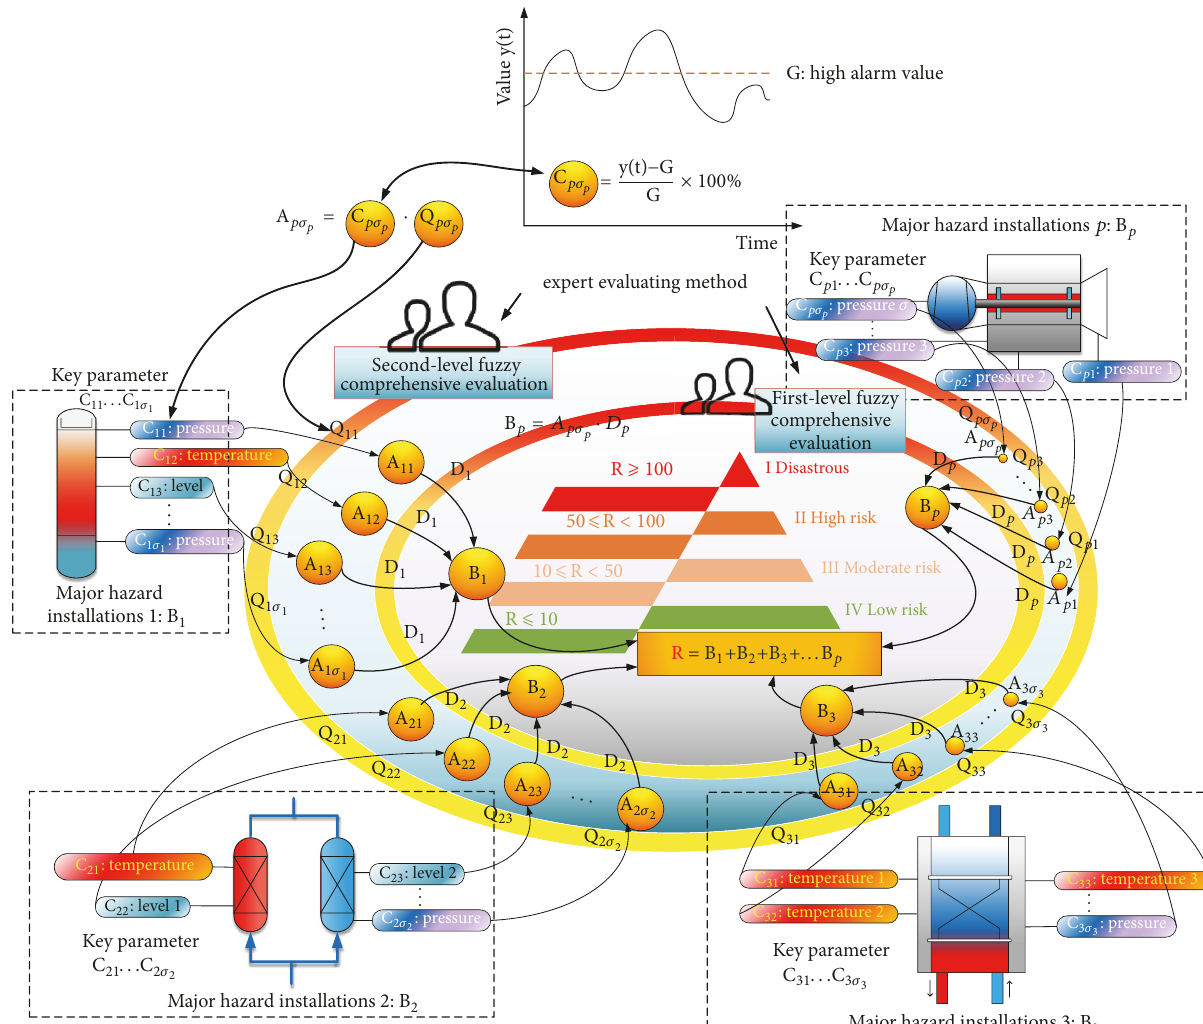
Figure 3: Hierarchical chart of dynamic assessment of